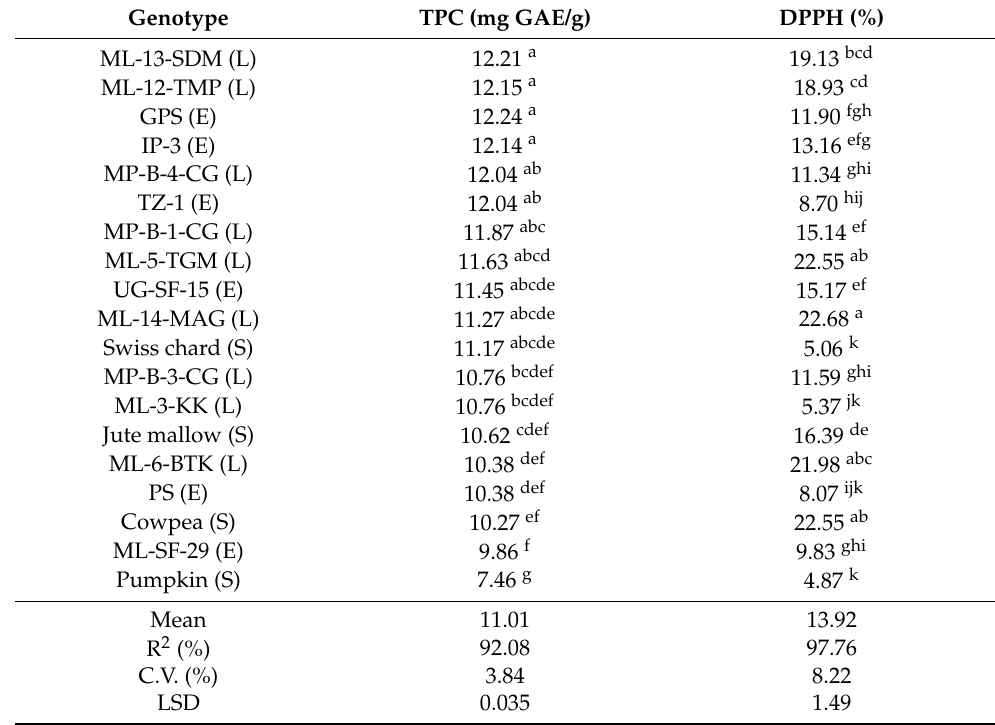
Table 3. Total polyphenol content and antioxidant activities of the spider plant genotypes, swiss chard, pumpkin, cowpea, and jute